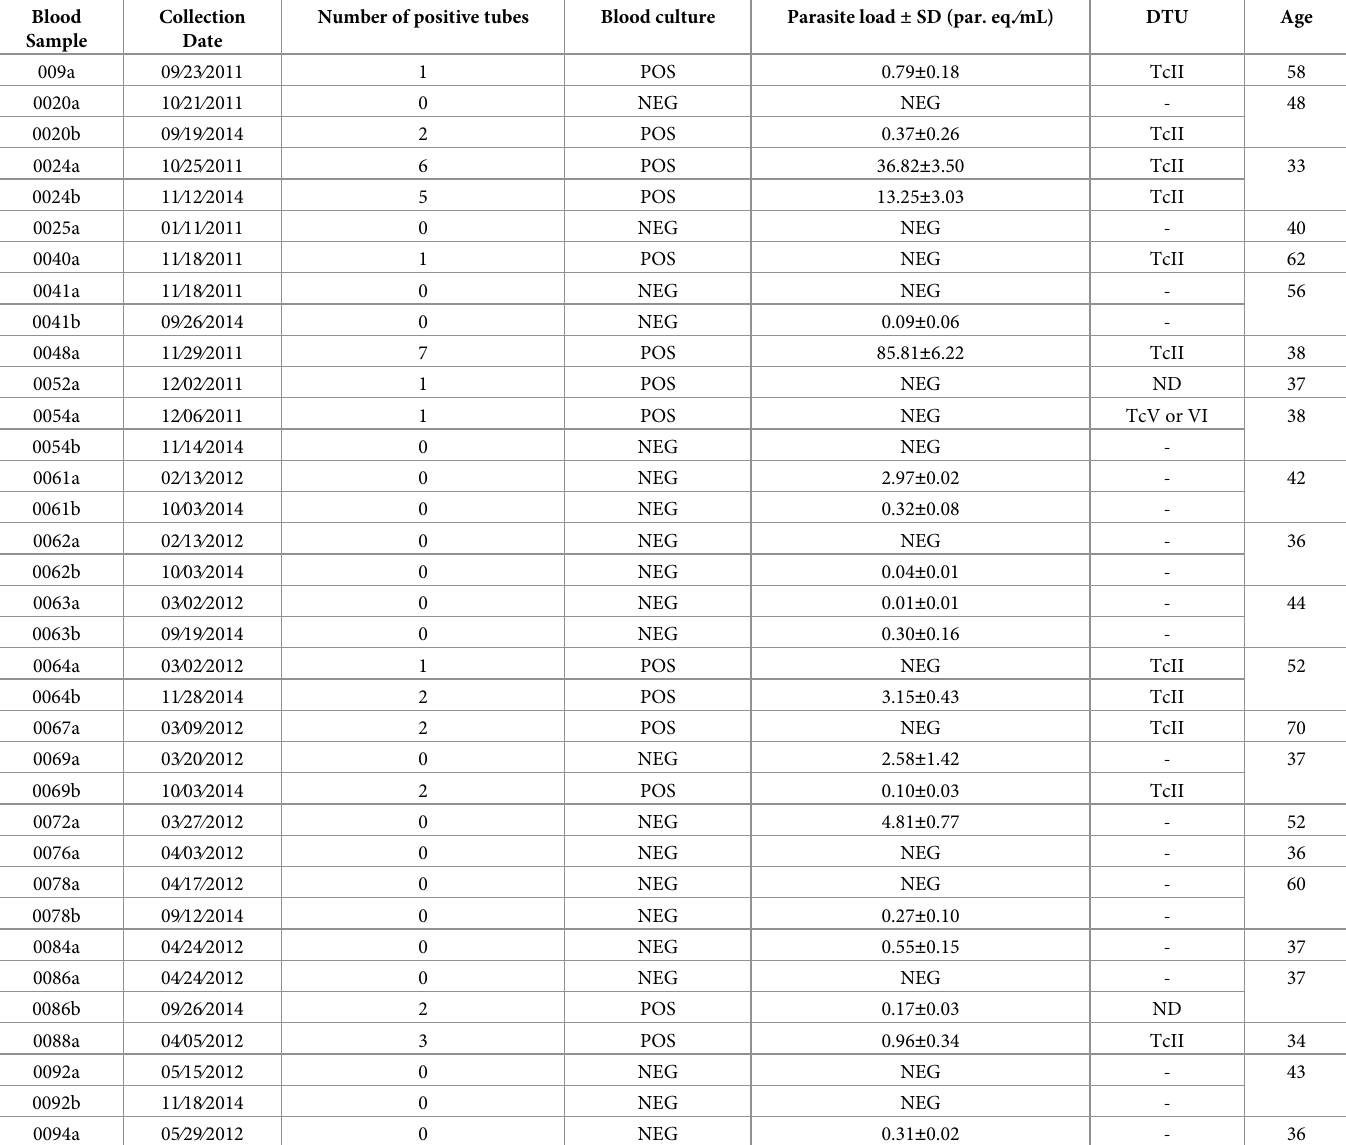
Table 1. Comparison of blood culture, T . cruzi genotype and parasite load in asymptomatic patients with chronic Chagas disease. Blood